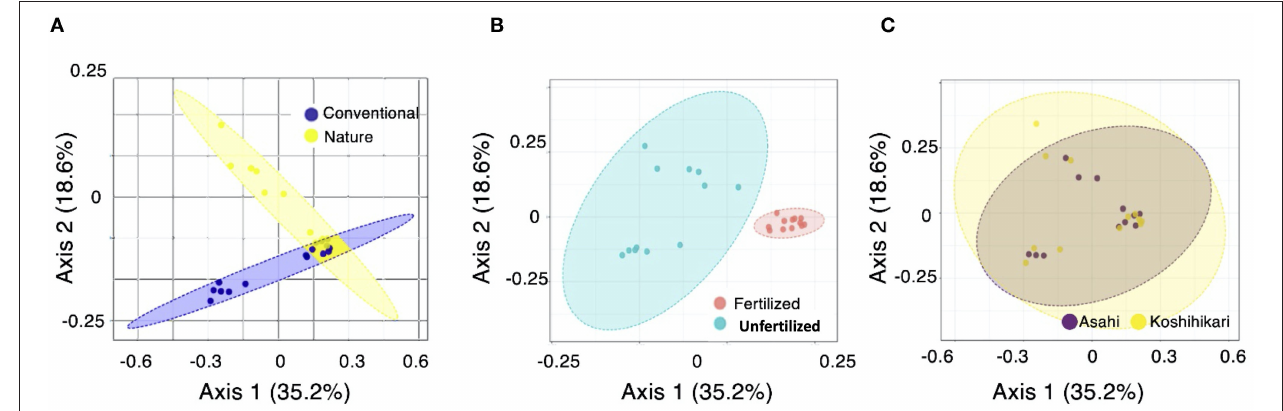
FIGURE 2 | Unconstrained principal coordinate analysis (PCoA) based on Bray-Curtis distance for the effects of (A) farming system, (B) fertilization treatments, and (C) rice cultivar factors on root microbial community